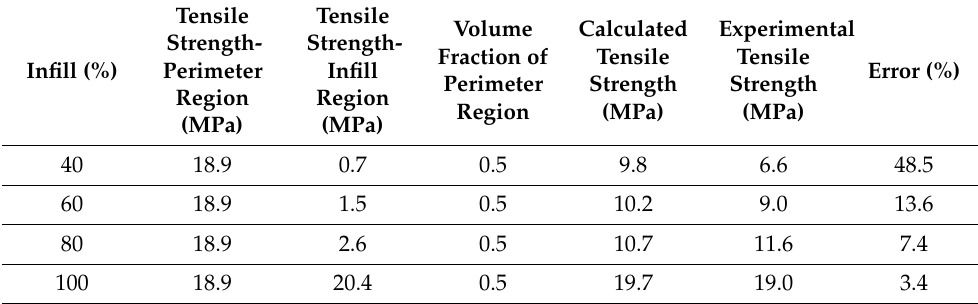
Table 10. Modelling results for the infill density set—transverse orientation (Method Table 9. Modelling results for the infill density set—longitudinal orientation (Method 2).